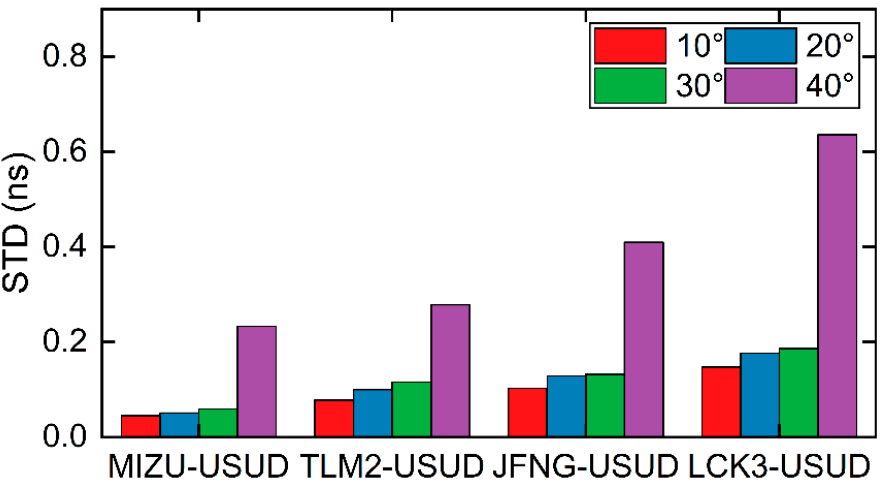
Figure 18. STDs of difference between B2b-RTPPP and GBM-PPP solutions. Table 6. The improvement of the B2b-RTPPP solution with mask angles of 10 ◦ , 20 ◦ , and 30 ◦ compared with the B2b-RTPPP solution with the angle of 40 ◦ at the STDs for the clock difference (%).